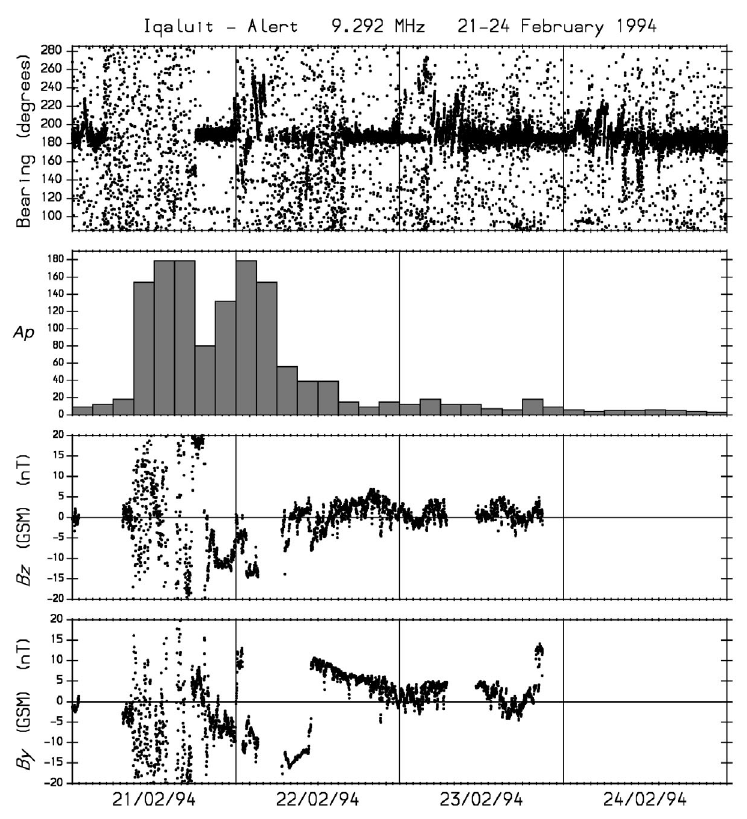
Fig. 14.6. Bearings measurements for the 9.292 MHz transmission from Iqaluit received at Alert for the peri- od 21st-24th February 1994. Three-hourly Ap values and the IMF By and Bz values are also shown. Bearings are measured in degrees clockwise from north, and the times/dates are in